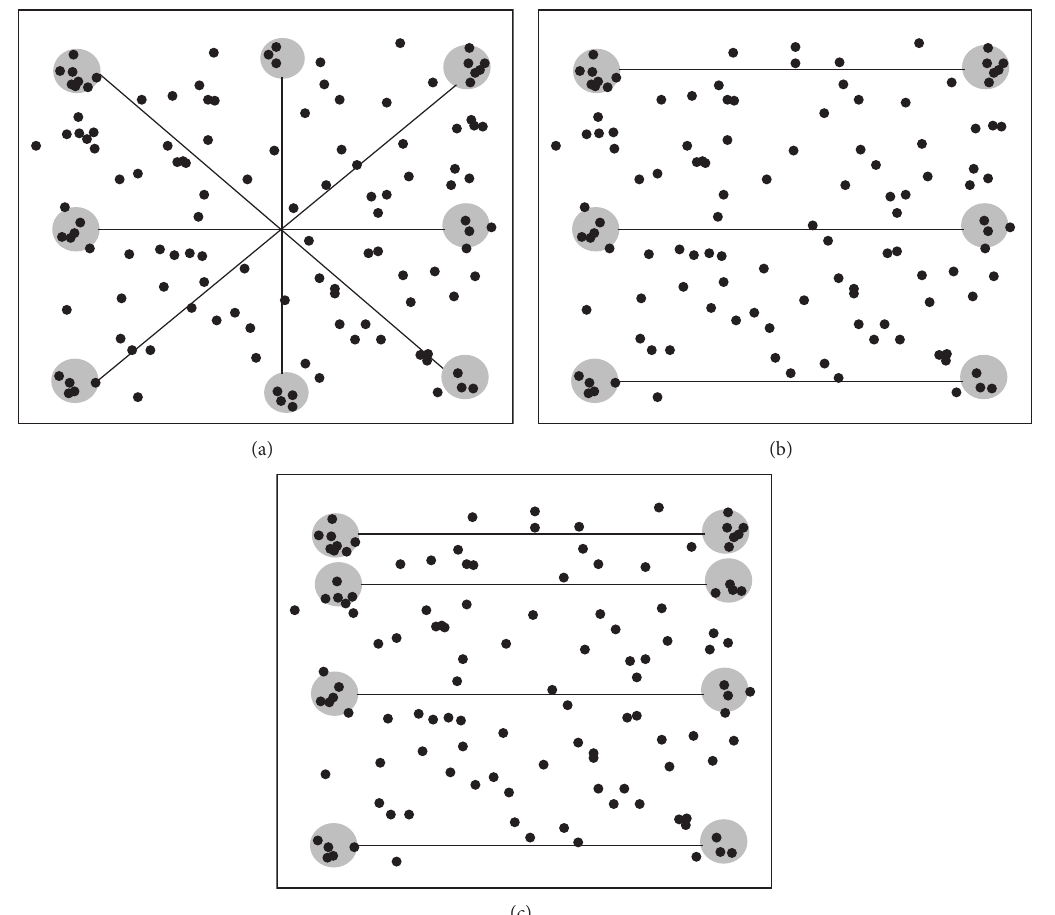
Figure 8: Multiple wormholes are placed at different positions of the network. (a) and (b) show wormhole links connected by long paths. Wormhole links connected by short path are shown in